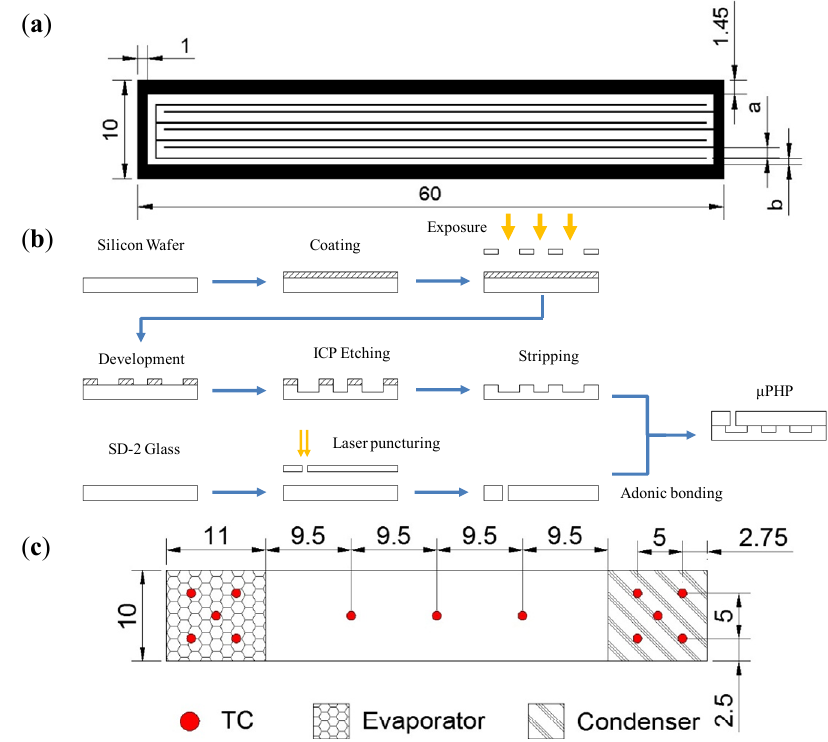
Figure 2. ( a ) Detailed dimensions of the micro pulsating heat pipes ( μ PHPs)